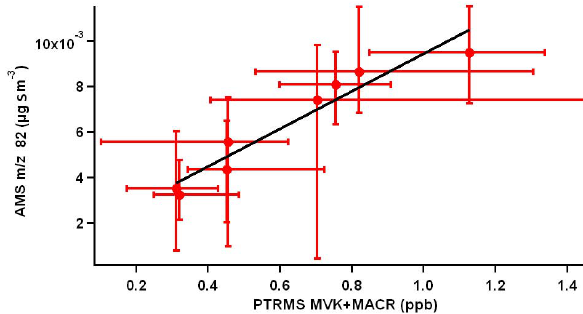
Fig. 5. AMS m/z 82 aerosol loading (inµg sm − 3 , defined asµgm − 3 at 273 K and 1013 hPa with no condensation of evaporation) vs. PTRMS gas phase MVK+MACR as measured in the boundary layer from the FAAM research aircraft. Each data point repre- sents the median of all boundary layer data collected during a single flight. Bars are 25th and 75th